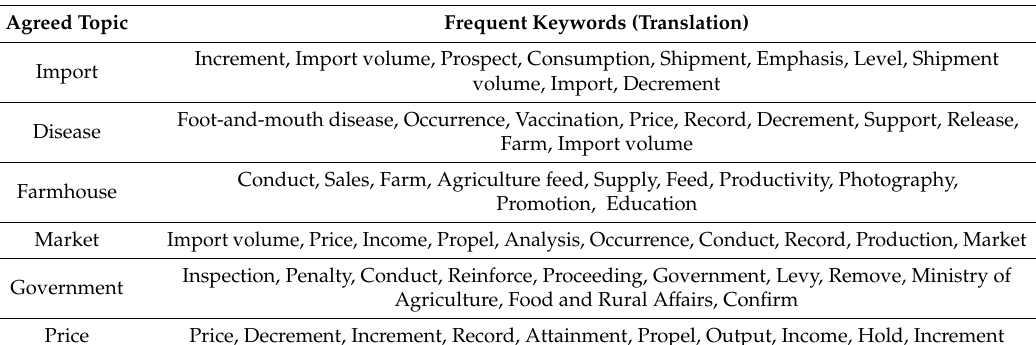
Table 3. Topics discovered from more than 10,000 news articles using LDA. Agreed Topic Frequent Keywords